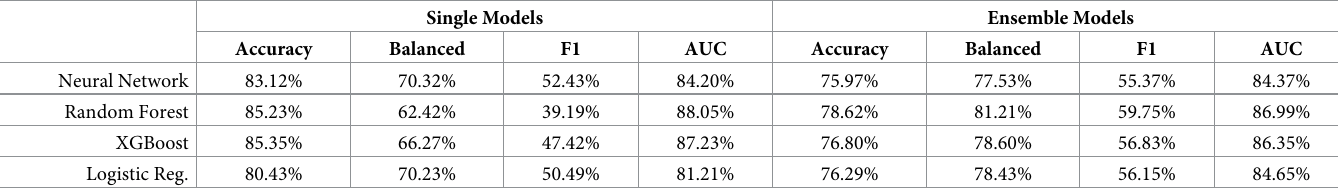
Table 7. Average performance comparisons between single models vs . ensemble models using all